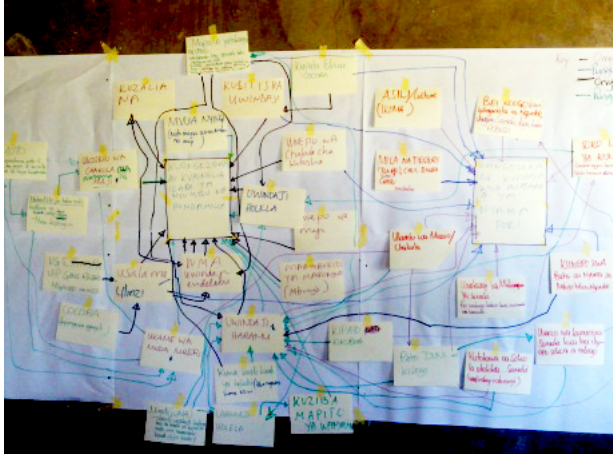
Fig. 3 . Photograph of fuzzy cognitive mapping (FCM) constructed in the workshop by the community that indicates conceptual links between zebra and bushmeat populations and bushmeat